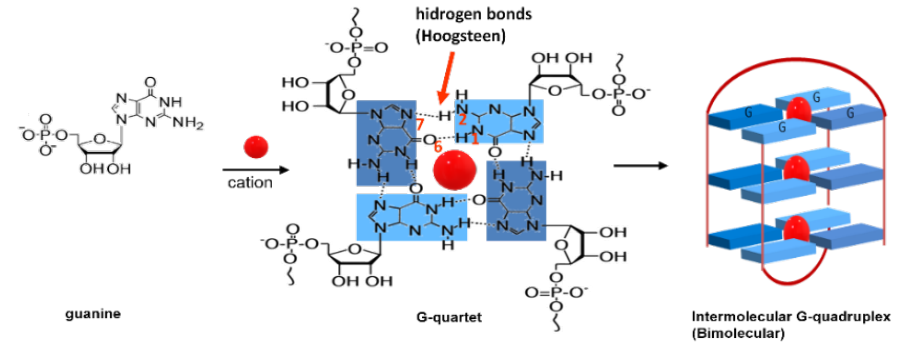
Figure 2. G-quartet and a possible G-quadruplex structure.